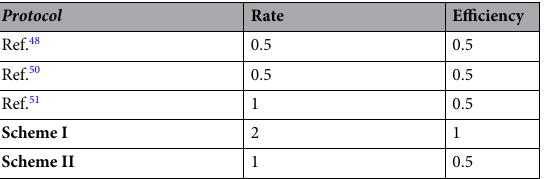
to Table 2: knowing her phase shift φ α as well as the polarization state of α and β , Alice learns the phase shift φ β of Bob. That is, Alice obtains a correlated key symbol with Bob.